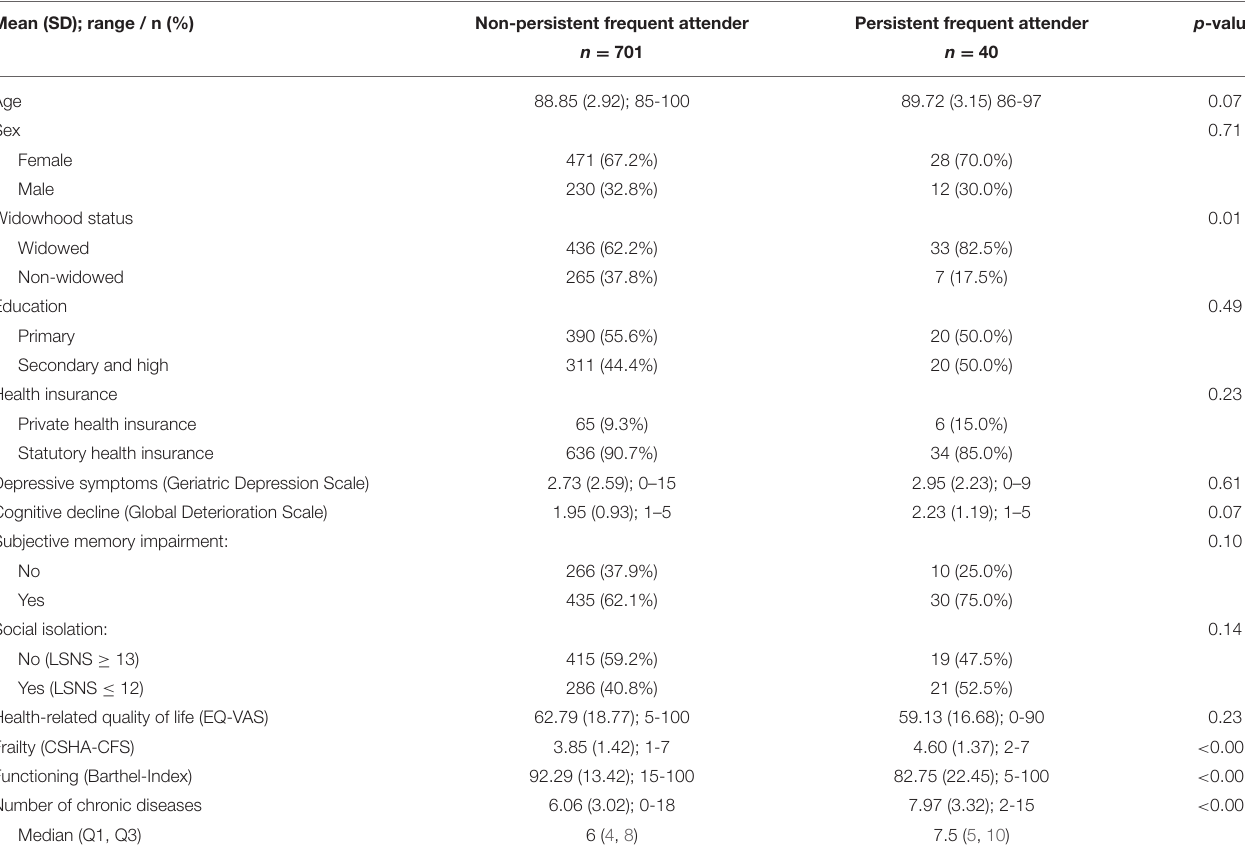
TABLE 1 | Descriptive characteristics of study cohort at baseline (FU7) - persistent frequent attender and nonpersistent frequent attender. Mean (SD); range / n